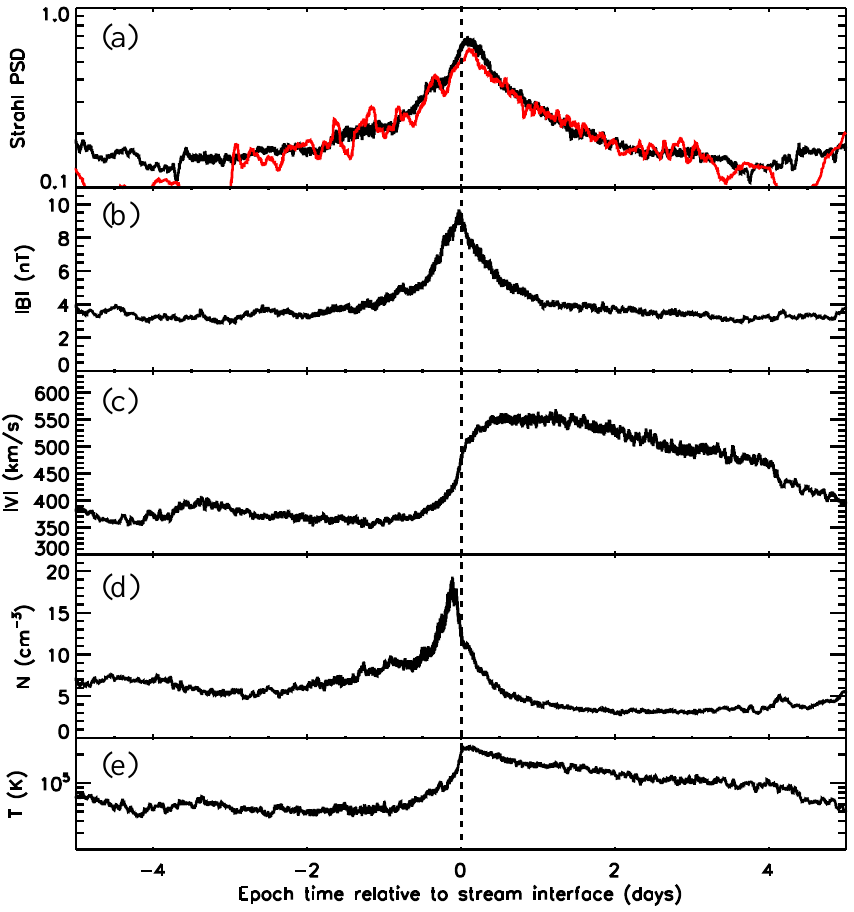
Fig. 8. Superposed epoch results from all data relative to the times of the stream interfaces of Table 2. Results are shown for (a) the strahl phase space density (arbitrary units), (b) the magnetic field magnitude, (c) the ion bulk solar wind speed, (d) the ion density, and (e) the ion temperature. In panel (a), the results for the strahl PSD during times of CSE only is also shown in red; it illustrates the fact that the strahl during CSE intervals has a similar strength, on average, as for other times. All curves are 100-point running averages of the superposed epoch dataset (cf. text for